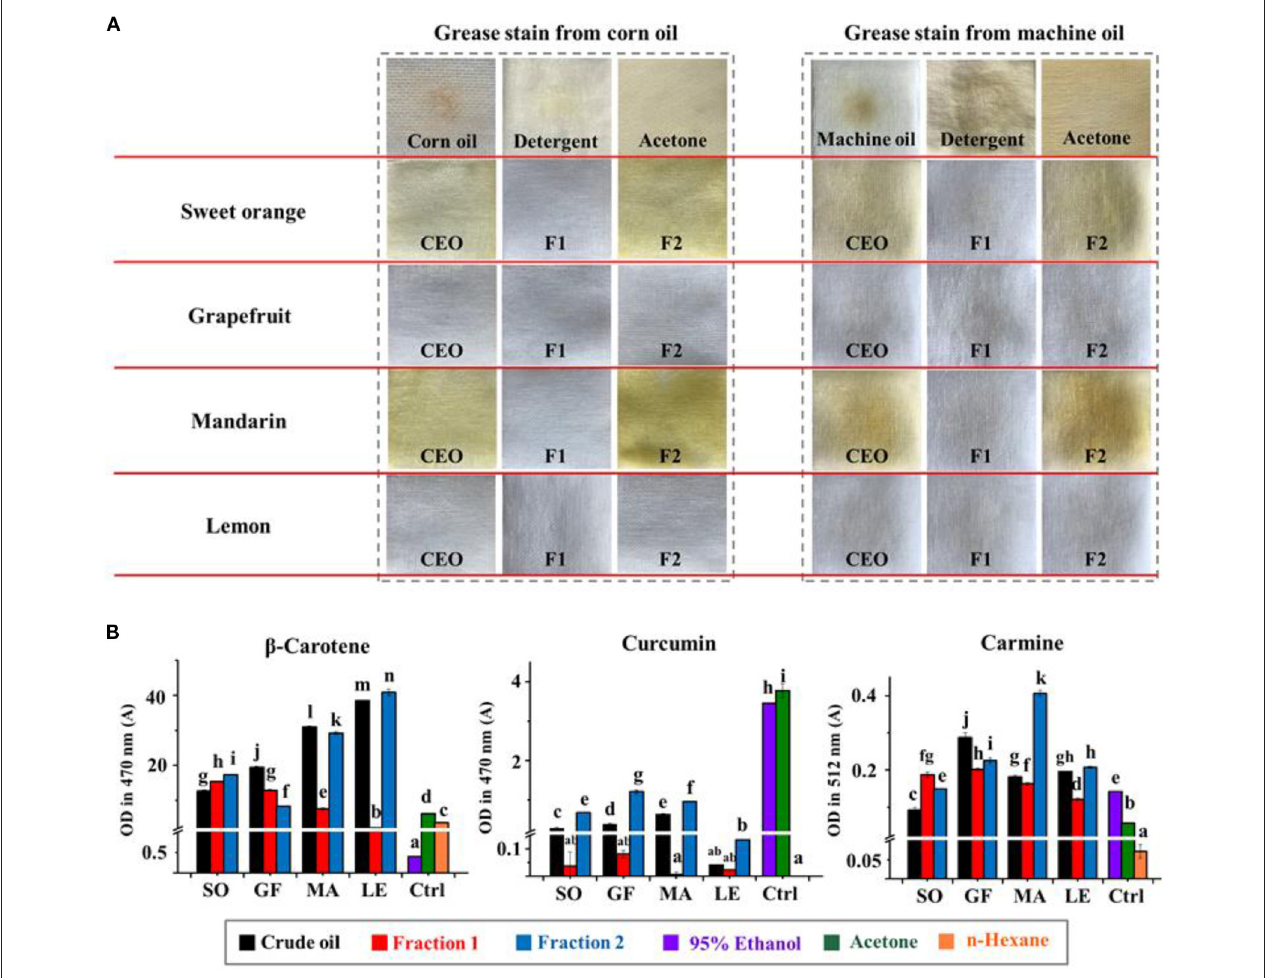
FIGURE 5 | (A) The degreasing abilities (corn oil and machine oil) of crude essential oils (CEOs) and Fractions 1 (F1) and 2 (F2) of SO, GF, MA, and LE. (B) The solubility of curcumin, β -carotene, and carmine in citrus EO samples. Ctrl indicates the control group, including 95% ethanol, acetone, and